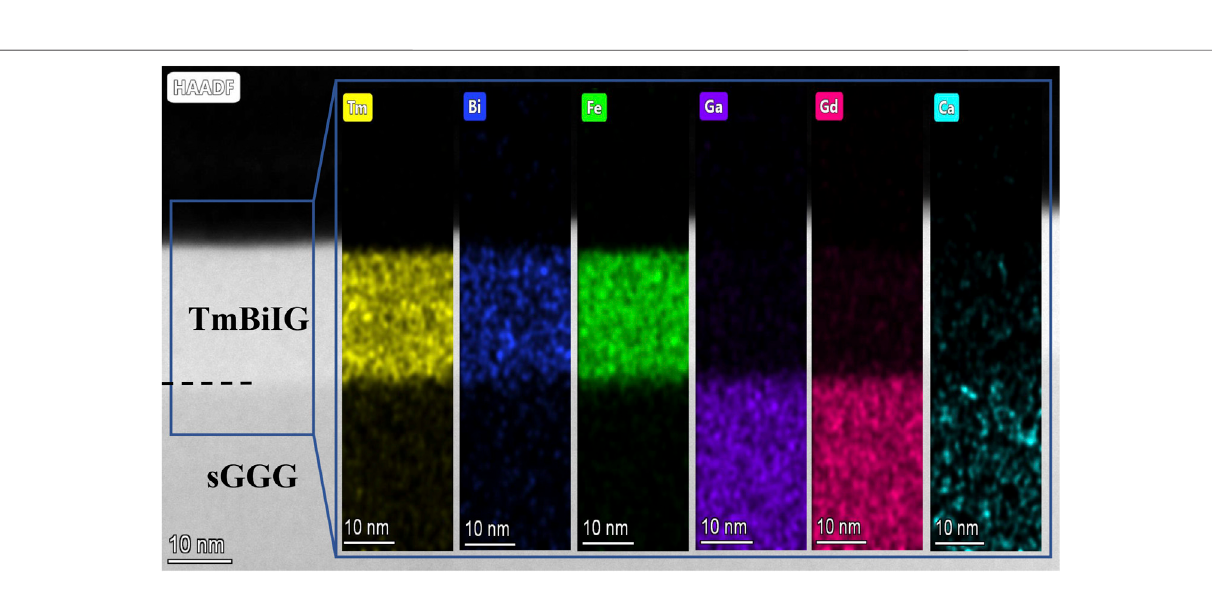
Frontiers in Materials |